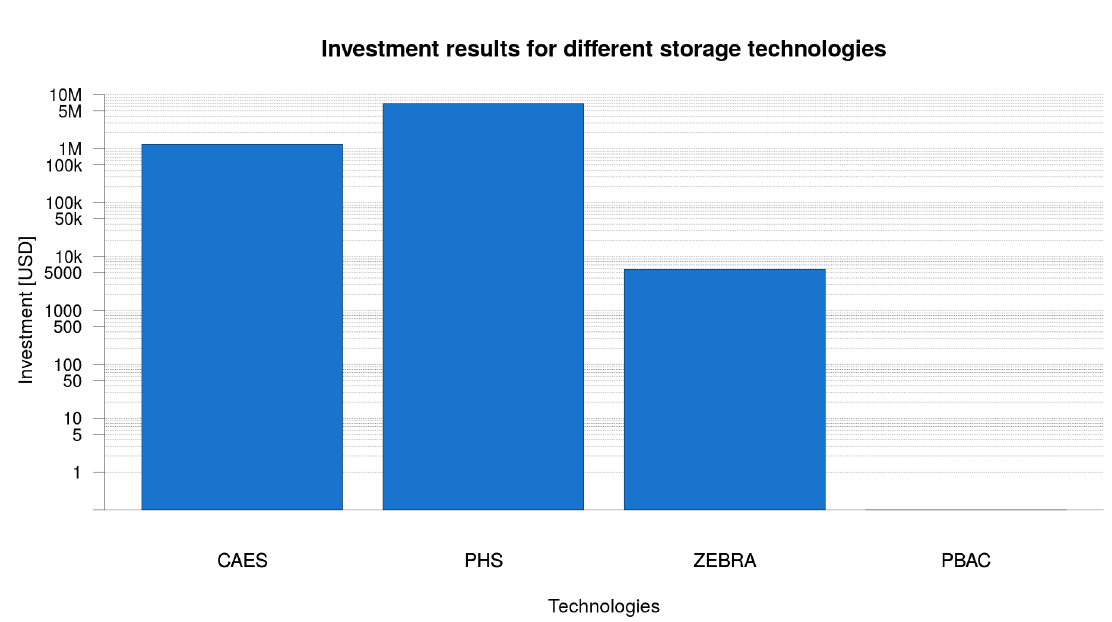
Figure 14. Investment results for the studied ESS technologies in